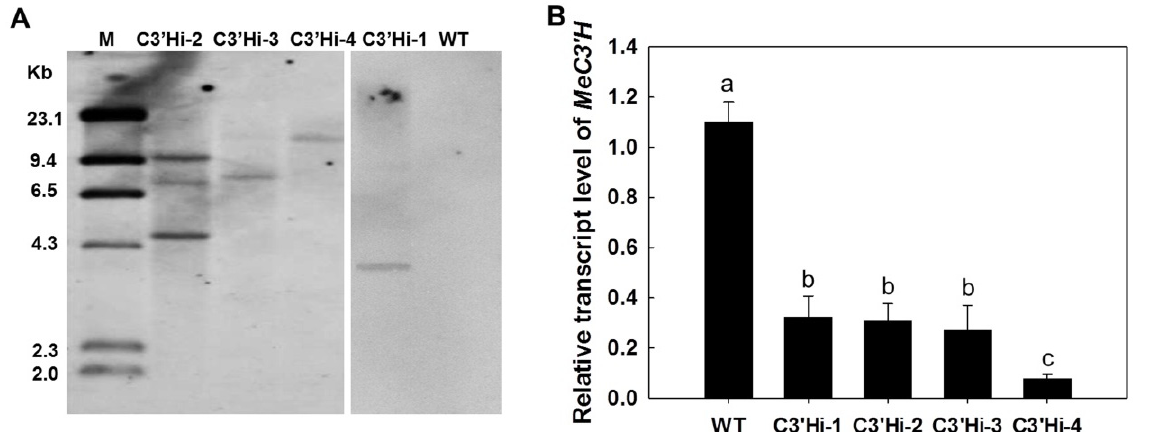
Figure 3. Analysis of transgenic cassava generated by Agrobacterium -mediated transformation. ( A ) Southern blot analysis of Hin dIII-digested genomic DNA from the leaves of transgenic cassava and WT using the HPT probe. There was only one restriction enzyme site in the T-DNA region. M: λ DNA molecular weight marker; WT: wild type; C3 ′ Hi-1–C3 ′ Hi-4: independent transgenic lines. ( B ) Transcript levels of MeC3 ′ H in transgenic plants and WT. β -actin was used as an internal control. Total RNA was extracted from leaves. Values labeled with different letters (a, b and c) at the different time points are significantly different according to Duncan’s multiple comparison tests at p < 0.05. Data are presented as means ± SD of three independent RNA samples.